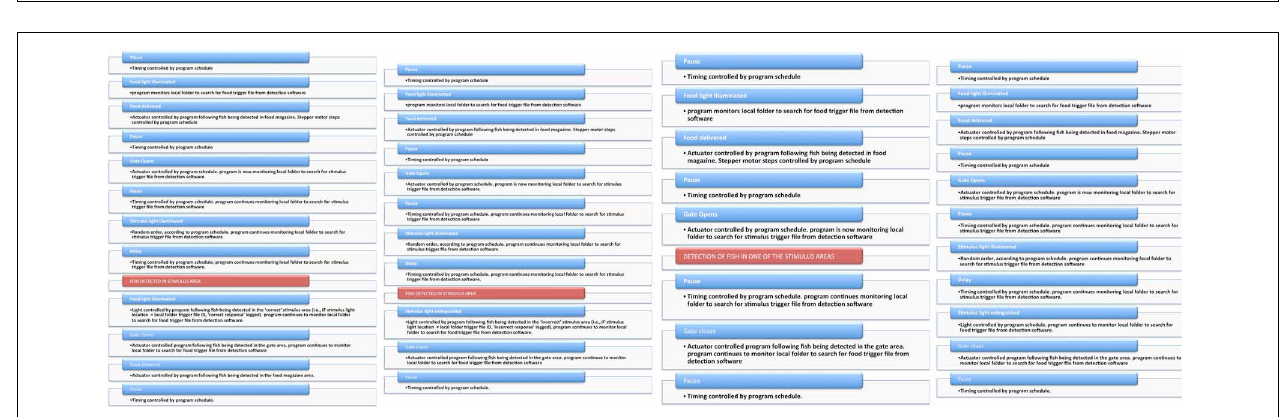
FIGURE 3 | Simplified workflow for LabView program. This figure shows the workflow of the LabView program during the course of training on the 5-CSRTT. The panels ( Left to Right ) depict the workflow (from the first trial) for trials with correct, incorrect and anticipatory responses, and omissions.